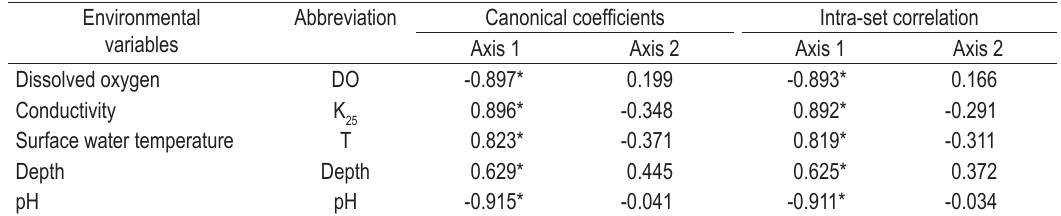
Table 4. Canonical coefficients and intra-set correlations of abiotic variables with the first two CCA axes. Environmental